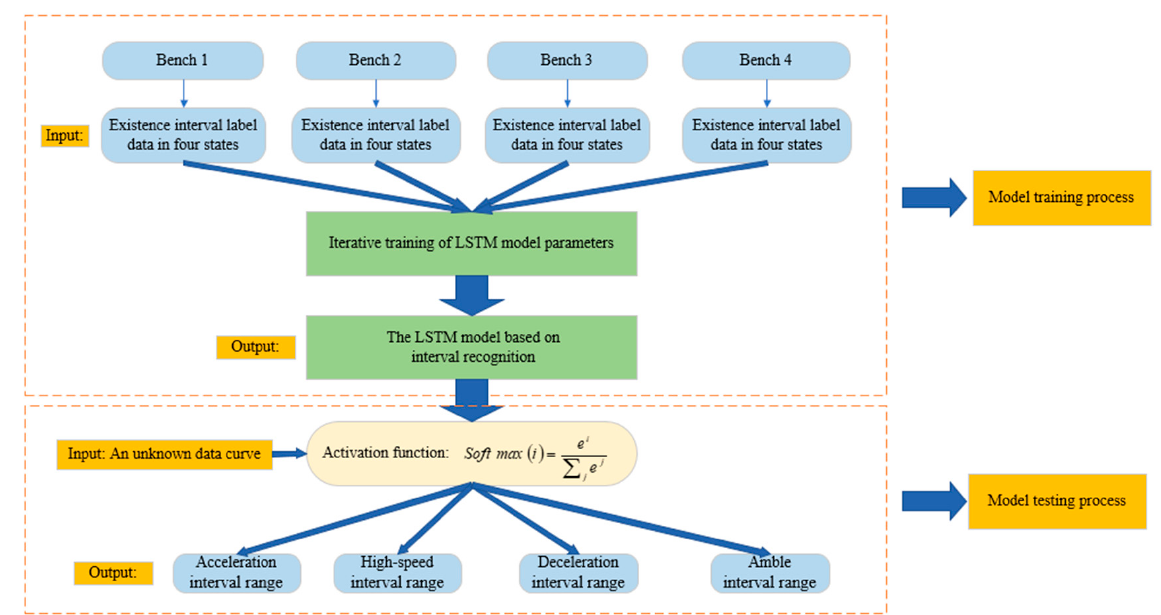
Figure 3. The structure of the LSTM model based on interval recognition.